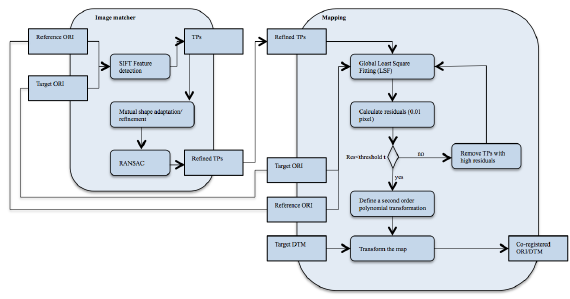
Figure 2 Flow diagram of HiRISE-CTX-HRSC co-registration We start with detecting feature points using the Scale Invariant Feature Transform (SIFT), which is widely used in image matching. However, this general feature based matching method assumes that the image features detected independently on each image are always correct. The repeatability of the detection is deteriorated when a significant distortion is involved in a matching image. Slight mismatch can bring a large impact on the global transformation. Therefore, we developed a Mutual Shape Refinement (MSR) algorithm that combines the scale and affine invariant feature detector with Adaptive Least Square Correlation (ALSC) to refine an approximated matching result and obtain more accurate Tie-Points (TPs). See Fig.3 for results. The algorithm of mutual shape refinement consists of i) Detection of a scale invariant feature and its scale ii) Iteratively update a circular scale invariant region to an elliptical region using a second moment matrix iii) Initial normalisation using the result from ii.